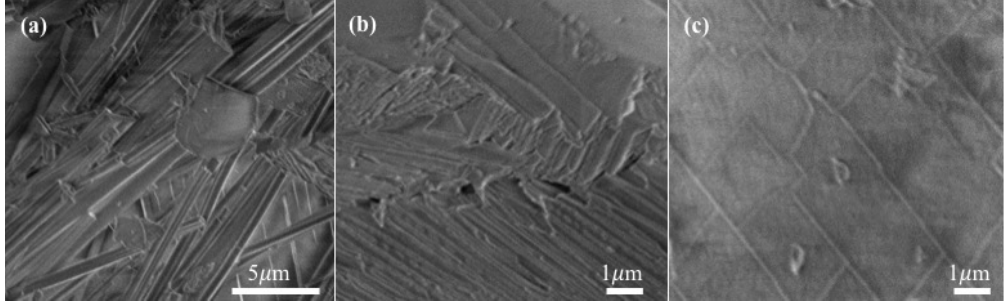
Figure 2. SEM images of crystals 1 with different magnifications ( a ) the global view; ( b , c ) enlarged images at different positions. The acceleration voltage is 2 kV.